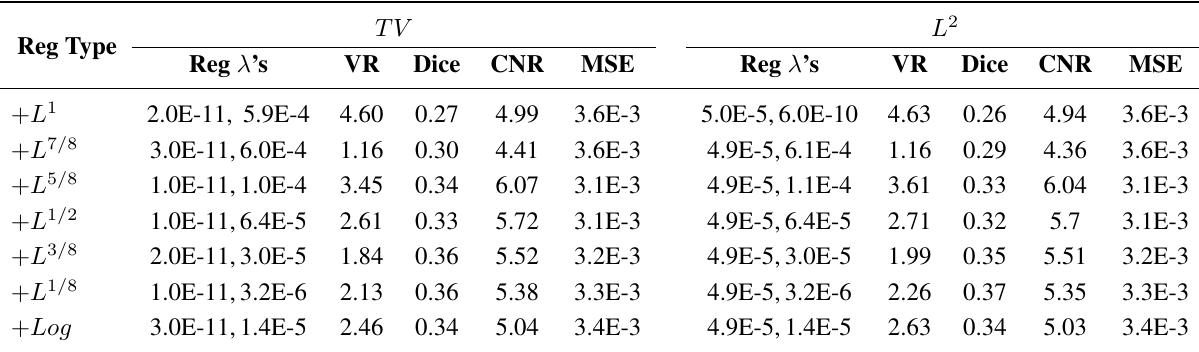
Table 2. Metrics of the best reconstructed images using combined regularizations for simulated small